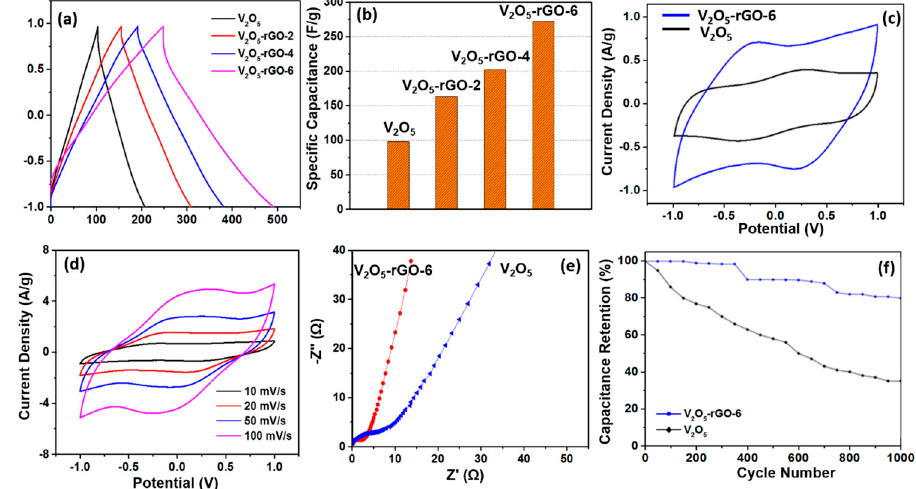
Figure 5. ( a ) Galvanostatic charge/discharge curves of the V 2 O 5 and V 2 O 5 -rGO hybrid aerogels with different ratios at a current density of 1 A/g; ( b ) summary of specific capacitance of the V 2 O 5 and V 2 O 5 -rGO hybrid aerogels; ( c ) CV curves of the V 2 O 5 and V 2 O 5 -rGO-6 hybrid aerogel at a scan rate of 10 mV/s; ( d ) CV curves of the V 2 O 5 -rGO-6 hybrid aerogel at varying scan rates; ( e ) EIS of the V 2 O 5 and V 2 O 5 -rGO-6 hybrid aerogel measured at a frequency of 0.01 HZ–100 kHZ; and ( f ) cycle stability of the V 2 O 5 and V 2 O 5 -rGO-6 hybrid aerogels tested at a current density of 10 A/g.